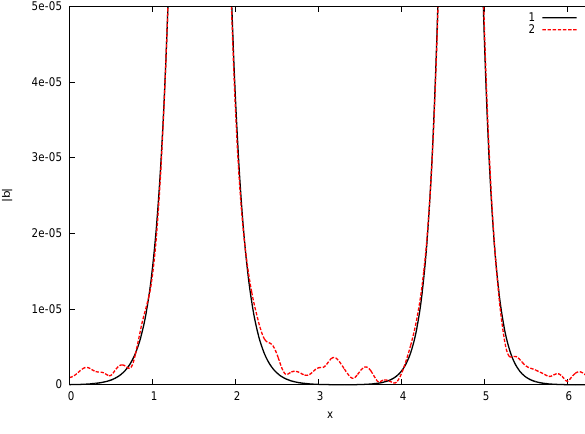
b k at the moment of first collision. | |